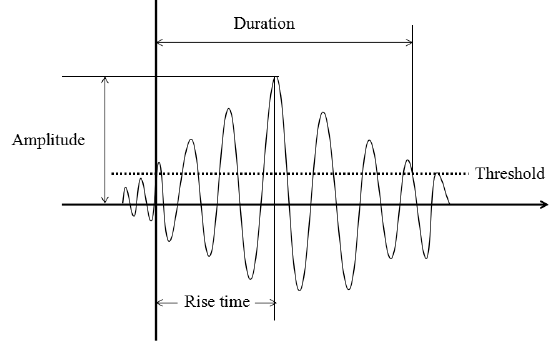
Figure 3. A typical waveform for a burst-type AE signal.